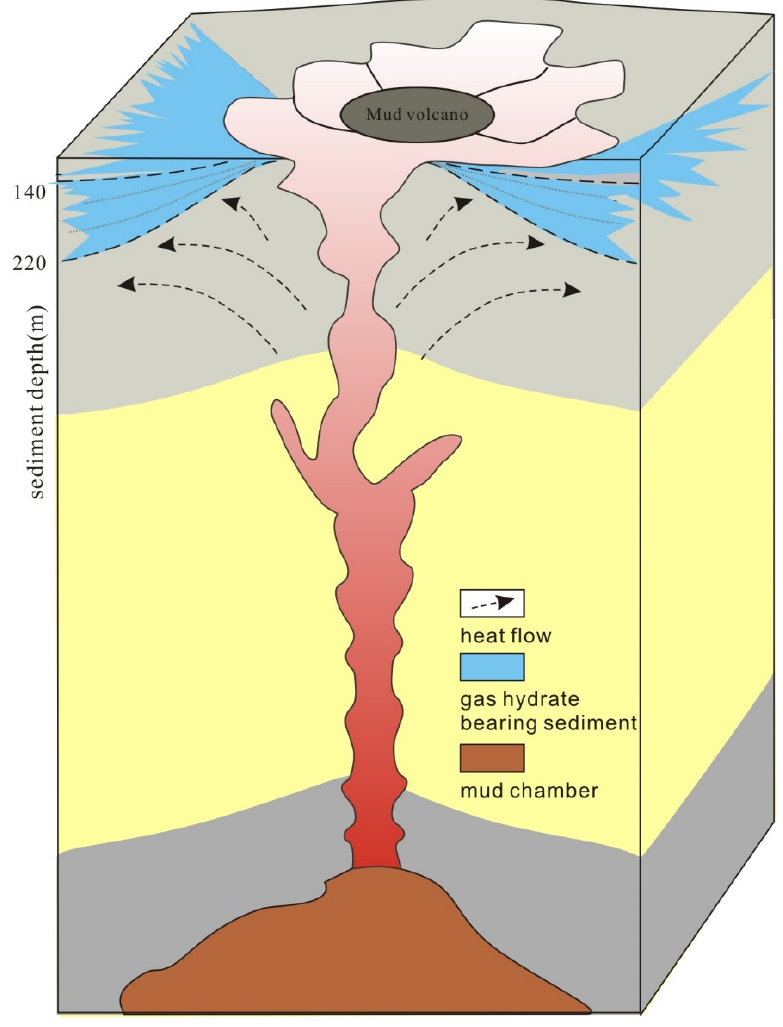
Figure 8. Schematic diagram of the hydrate occurrence pattern in the mud volcano development area. The model represents the distribution rule of hydrates in the shallow layer around the mud volcano after the mud volcano eruption. The temperature contour represents the bottom of the hydrate stability zone, and the arrow represents the direction of heat flow.